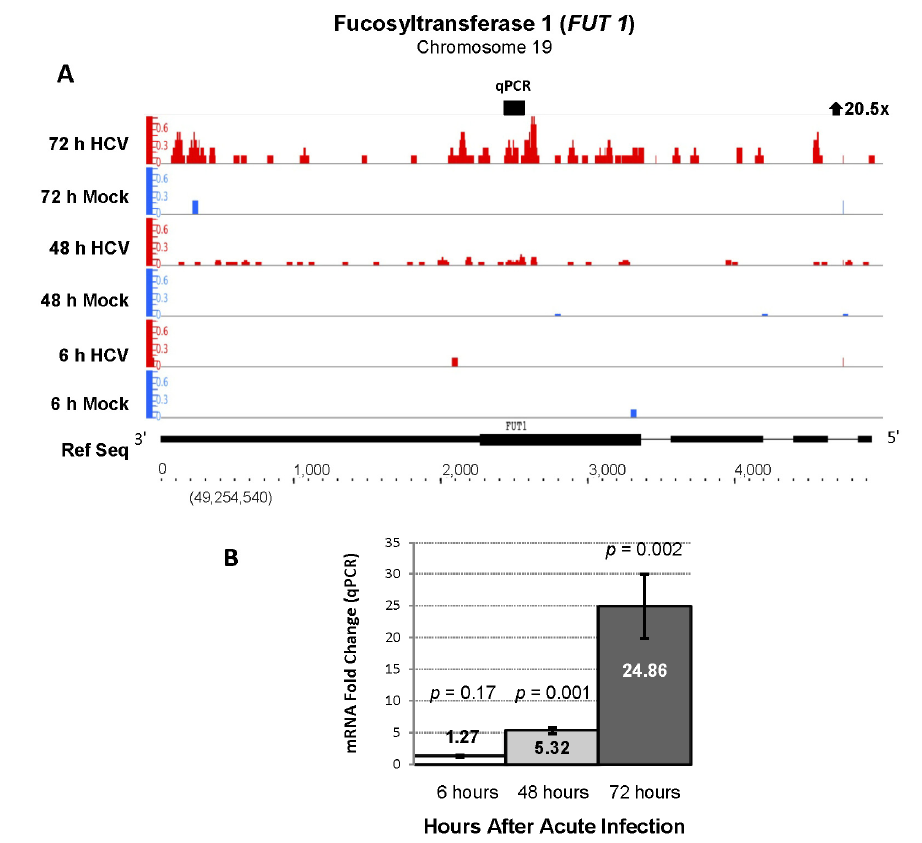
Figure 3. Increased expression of fucosyltransferase 1 ( FUT1 , Chr 19, − strand) during acute HCV infection. ( A ) RNA sequencing analysis of acutely HCV infected cells showed a 20.5-fold increase in FUT1 gene expression with a highly significant FDR of 105 (represents <0.0000000001 false positives out of 100). Gene expression is displayed as the number of 36nt sequencing reads per kilobase of gene length per million reads (RPKMI) using the Integrated Genome Browser (IGB) (Experimental Procedures). The y-axis represents RPKMI, and x-axis represents chromosome location and gene structure. To present a better view of gene exon structure, the IGB sliced view that minimizes the size of intronic regions was used. RNA sequencing reads from a pool of three replicates of HCV infected cells at 6, 48 and 72 h are shown in red and mock-infected cells in blue. Gene structure (in kilobases), orientation and chromosomal location (gene start provided in parenthesis) are shown in the lower part of the panel next to Ref Seq. ( B ) Quantitative PCR (qPCR), although it measures only one specific region of transcript expression unlike sequencing analysis, was used to validate the RNA-seq results. Six mock infected and six HCV infected Huh 7.5 cell cultures (9.6 cm 2 ) were analyzed by qPCR (n = 3 for each culture, total of n = 18) at each time point. qPCR analysis showed a 24.8-fold increase in mRNA at 72 hours after HCV infection. The qRT-PCR data represent the mean ± SEM and the location of qPCR primers is indicated in the IGB schematic in Panel A. p -values were calculated using the Student's t-test, and p values <0.05 were considered